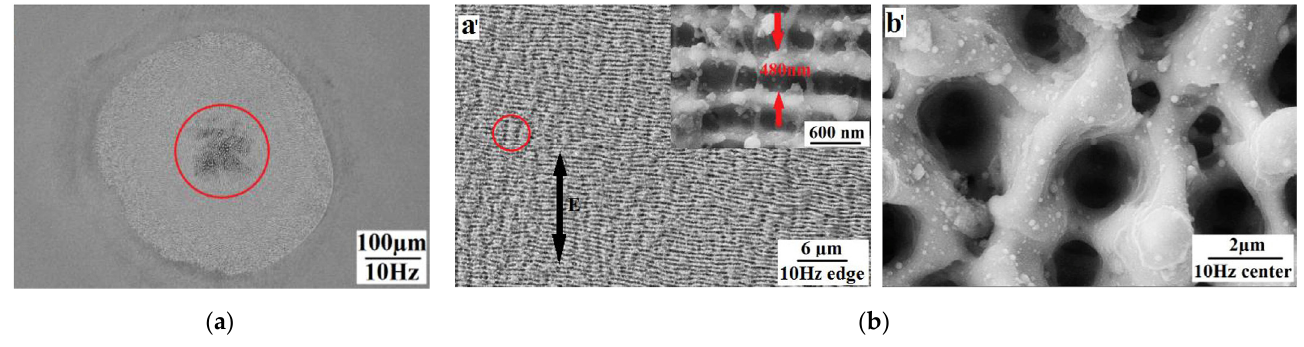
Figure 6. Moth-eye-like structure on 304 stainless steel with repetition rate of 10 Hz. ( a ) Whole ablated area; ( b ) detailed view of micro/nanostructures in peripheral ( a’ ) and core region ( b’ ). “Reprinted with permission from Ref. [32], Copyright (2017), Elsevier”.